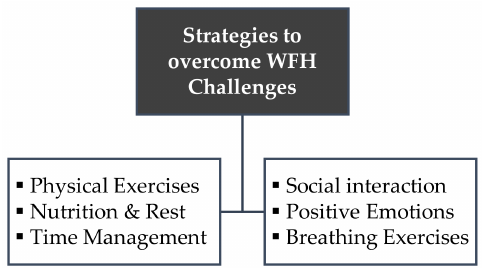
Figure 2. Strategies to overcome WFH